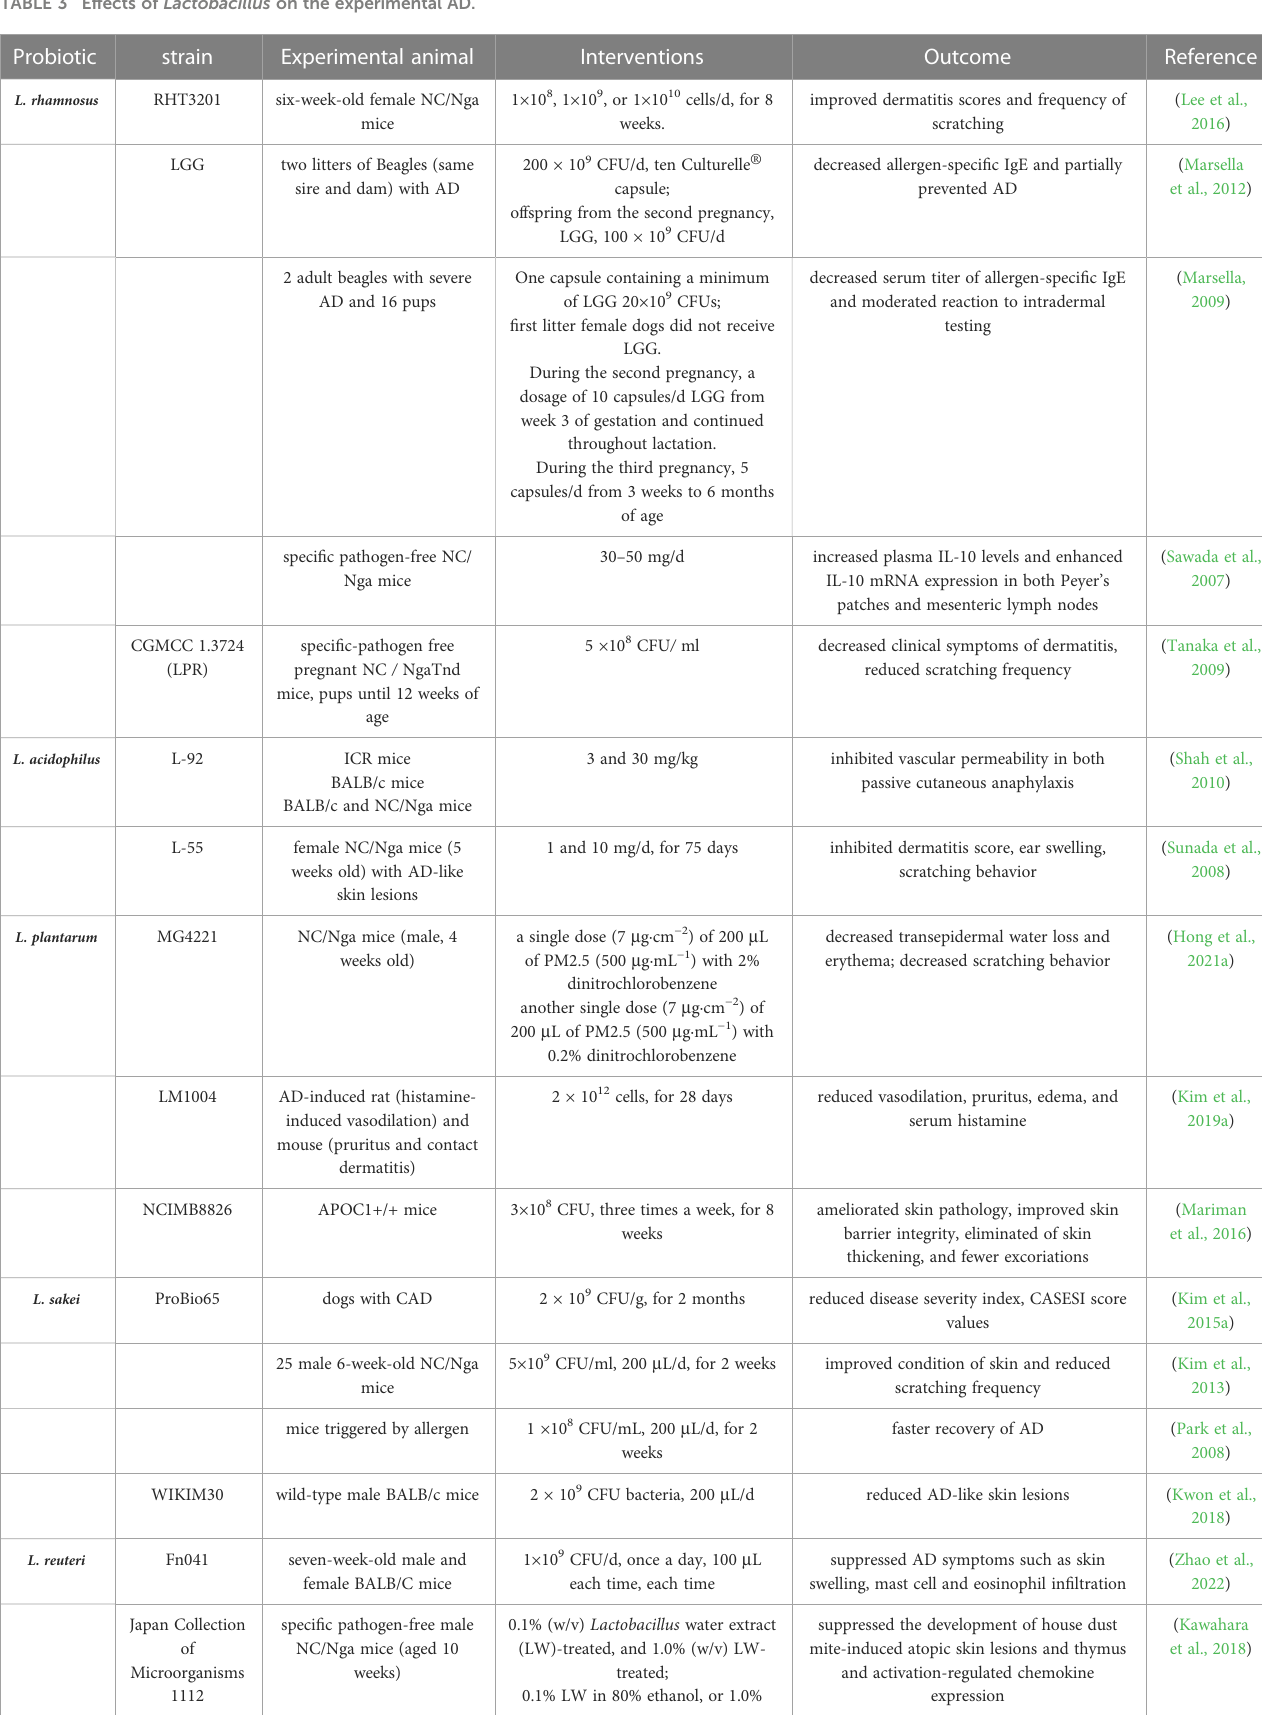
TABLE 3 Effects of Lactobacillus on the experimental